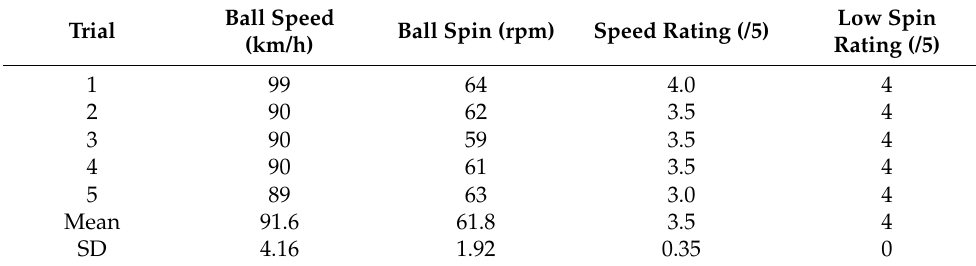
Table 1. Dynamics of typical trajectory of soccer ball trial.